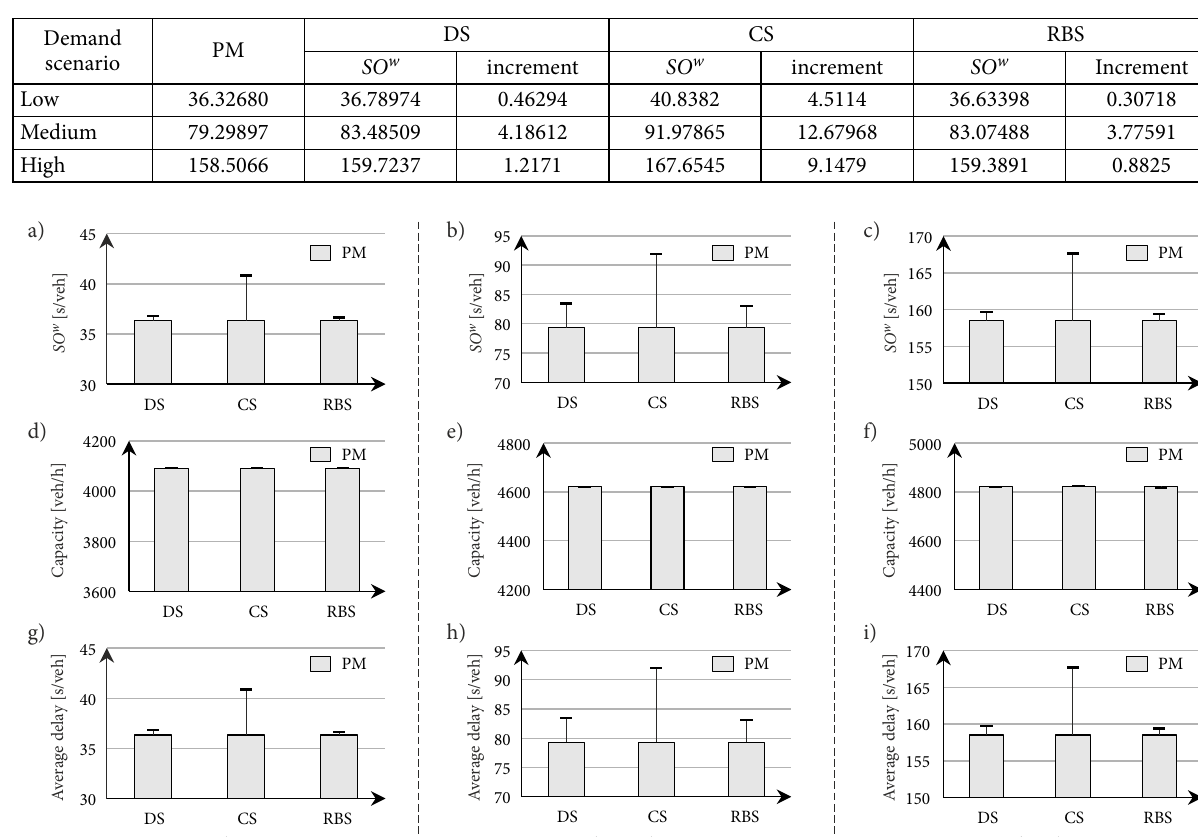
Table 9. Results comparison of the objective values